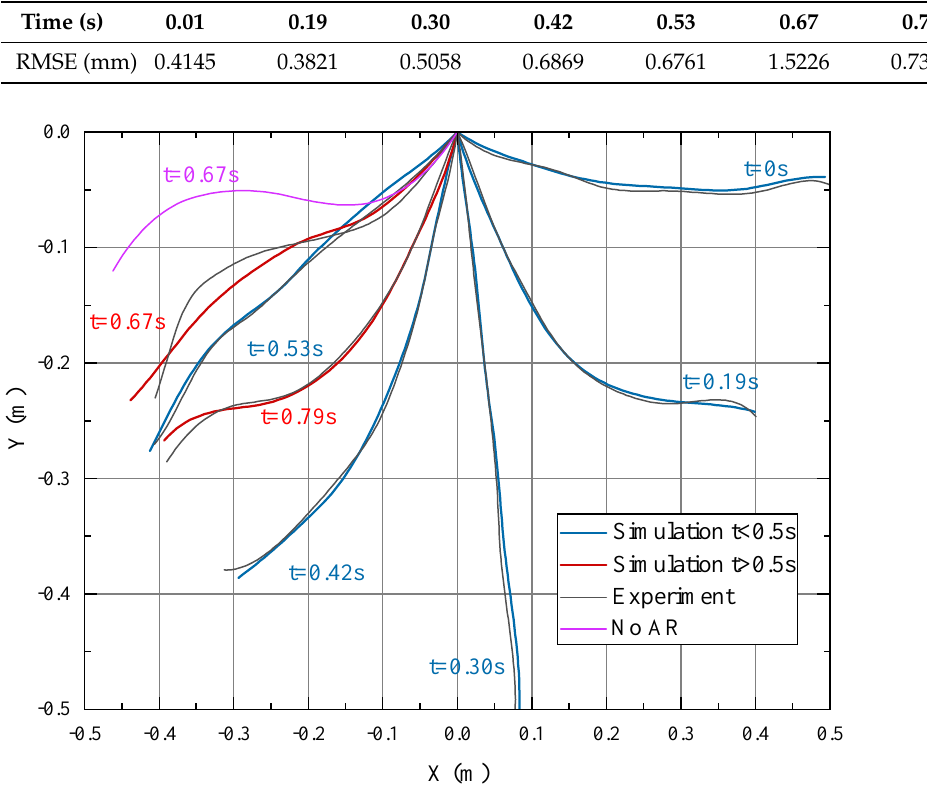
Figure 10. The comparison between the fitting curve of experiment and the simulation curve in different